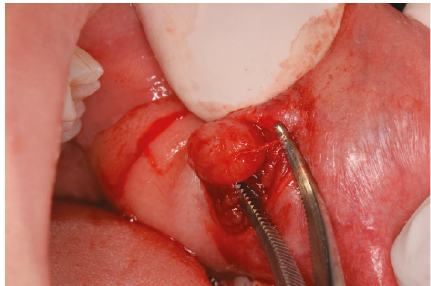
Figure 1: Surgical excision of the